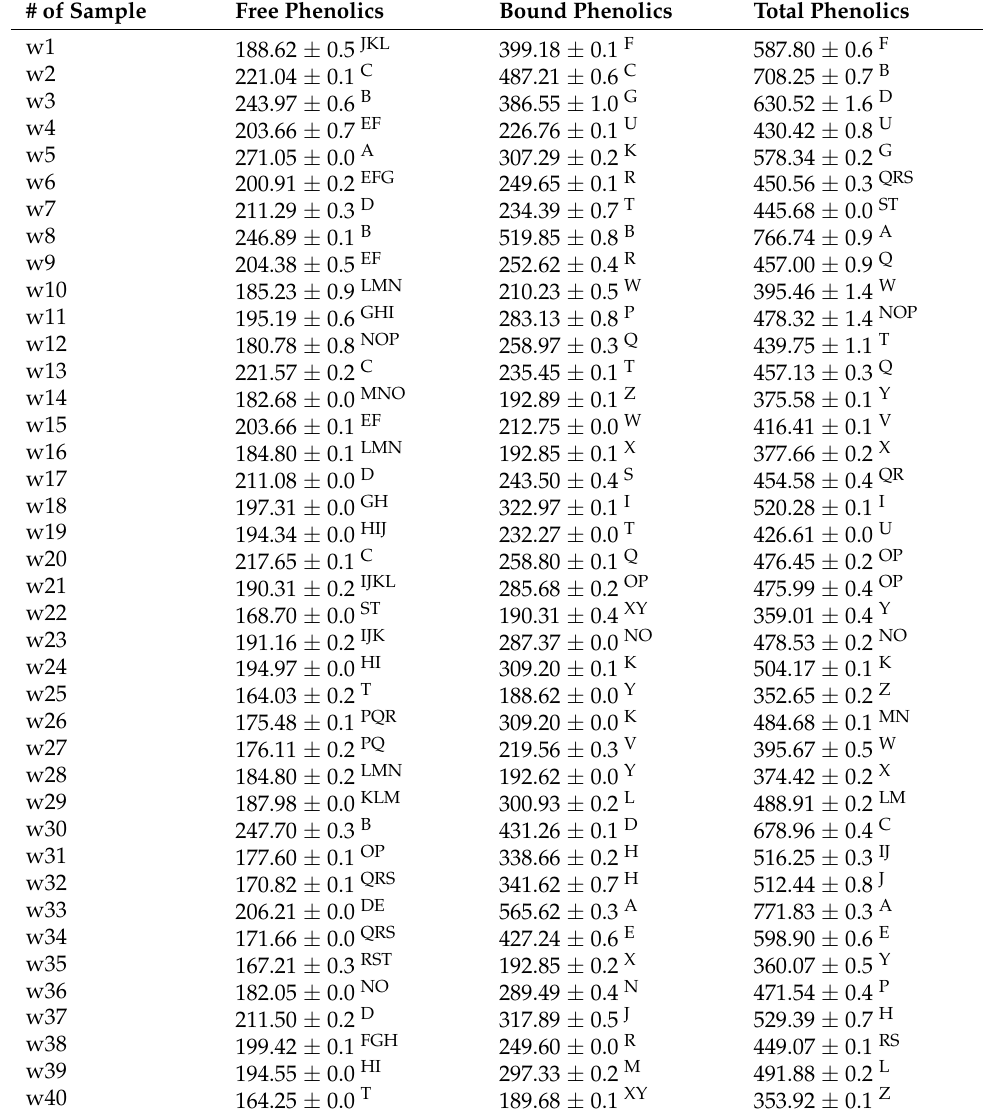
Table 2. Free, bound, and total phenolic content of purple wheat samples (mg GAE/100g). # of